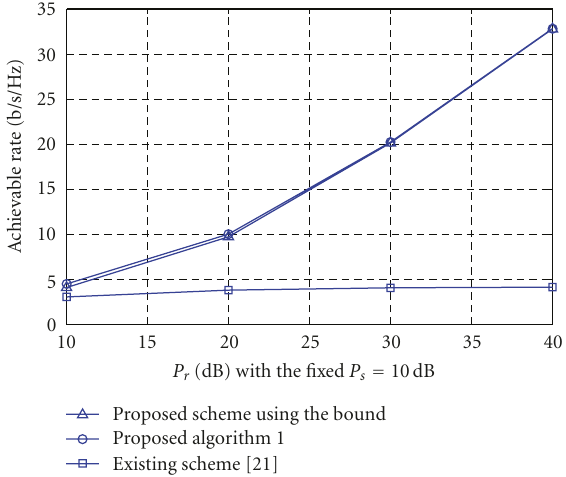
Figure 4: Achievable rate comparison at di ff erent values of subtotal power of relays when K = 4.